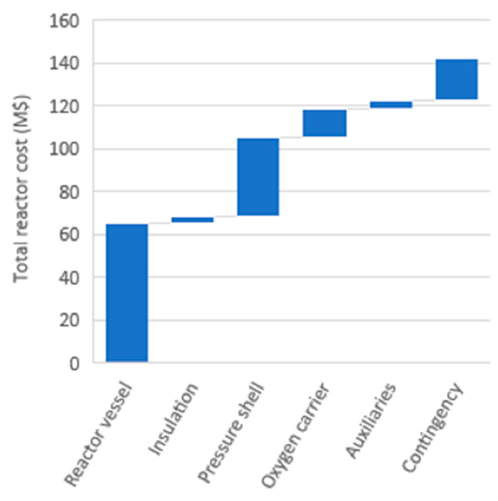
Figure 4. Breakdown of the cost of 20 ICR units.